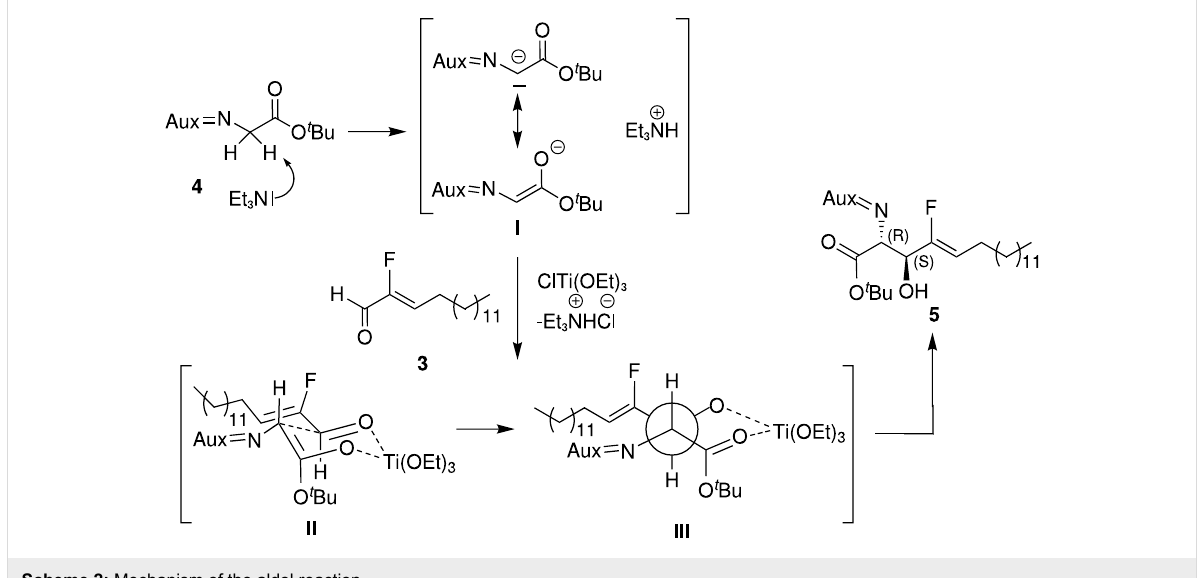
Scheme 2: Mechanism of the aldol reaction.